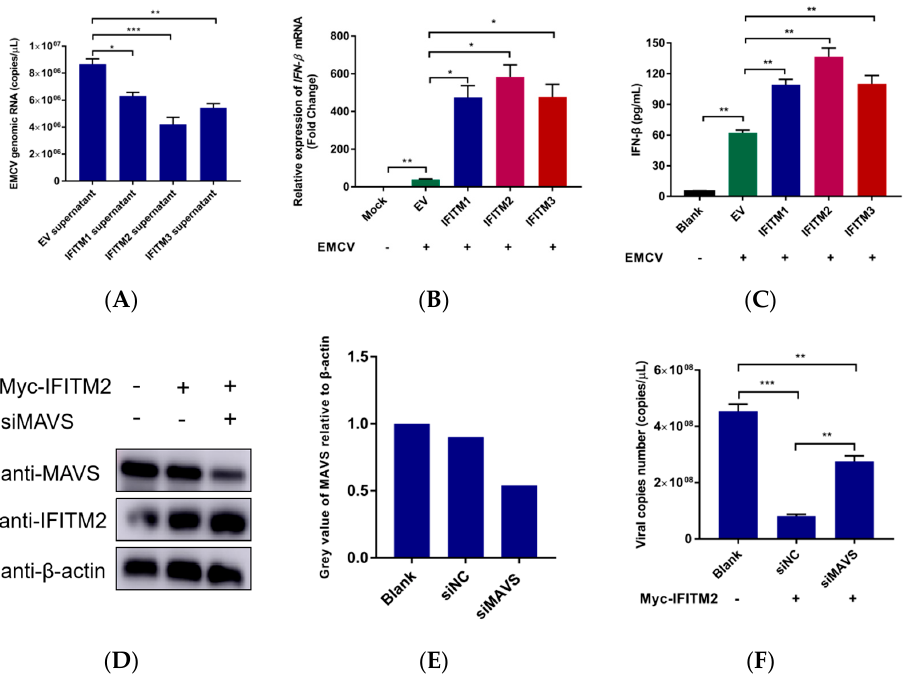
Figure 4. HEK293 cells were transfected with Myc-IFITM1 (1 µ g), -IFITM2 (1 µ g), or -IFITM3 (1 µ g) plasmid, respectively. pCMV-Myc empty vector (1 µ g) served as control. ( A ) Cell culture supernatant was collected 24 h post-transfection and added to EMCV infection cells, serving as a sustainable medium. Virus-infected cells were cultured for another 24 h, then collected for viral RNA extraction. Viral genomic copies were detected using real-time PCR using specific primers. ( B ) 24 h post-transfection, cells were infected with 0.001 MOI EMCV for 12 h. Cellular RNA was extracted for IFN- β mRNA detection via RT-qPCR. Data were normalized to β -actin expression. ( C ) IFN- β concentrations in the culture supernatant of overexpression IFITM proteins were detected via ELISA according to the manufacturer’s instructions. Data were expressed as mean ± SDs from three independent experiments and were measured in technical duplicate. Comparisons between groups were performed using the Student’s t -test. *** p < 0.001, ** p < 0.01, * p < 0.05. ( D ) HEK293 cells were transfected with or without siRNA-targeting MAVS for 24 h, followed by IFITM2 overexpression for another 24 h. Then, cells were collected for MAVS and IFITM2 detection used specific antibodies. β -actin served as the loading control. ( E ) Greyscale analysis was used to measure the protein expression level of MAVS proteins relative to β -actin. ( F ) HEK293 cells were transfected with siRNA NC or siRNA-targeting MAVS for 24 h, followed by IFITM2 overexpression for another 24 h. Then, cells were infected with 0.01 MOI EMCV for 24 h. Virus was collected for RNA extraction and viral copies number was detected via real-time TaqMan PCR. Data were expressed as mean ± SDs from three independent experiments and were measured in technical duplicate. Comparisons between groups were performed using the Student’s t -test. *** p < 0.001, ** p < 0.01.